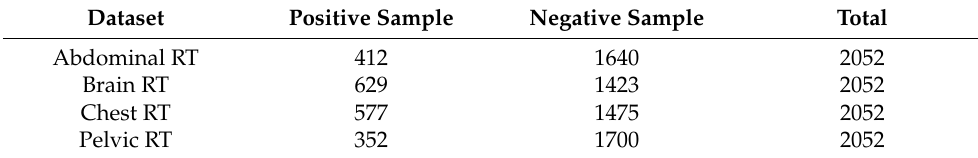
Table 1. Sample size of patients treated with different radiotherapy